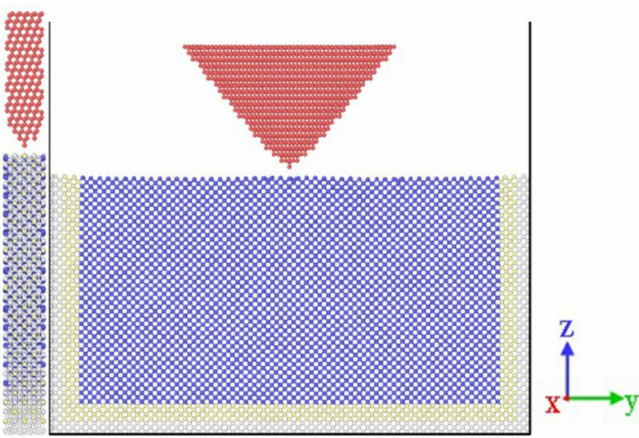
Figure 9. Nanoindentation model